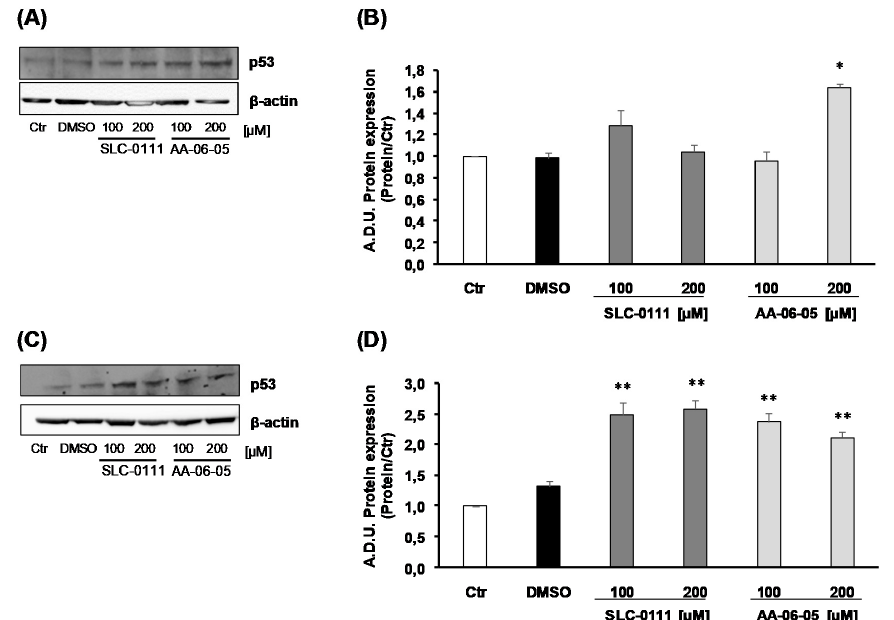
Figure 4. CA-IX inhibition allows the increased expression of apoptotic protein p53 in MDA-MB-231 and A549 cells. MDA-MB-231 ( A , B ) and A549 ( C , D ) were treated SLC-0111 and AA-06-05 [100–200 µ M] for 1 h. The treatments were performed under experimental condition of medium with 1% FBS. Signals were evaluated through western blot and β -actin was used to normalize loading. For each experimental condition, Arbitrary Densitometry Units (A.D.U.) ± SD were reported as p53 / β -actin vs basal control. ( n = 3). * p < 0.05, ** p < 0.01 vs. untreated cells (Ctr). Int. J. Mol. Sci. 2020 , 21 , x FOR PEER REVIEW